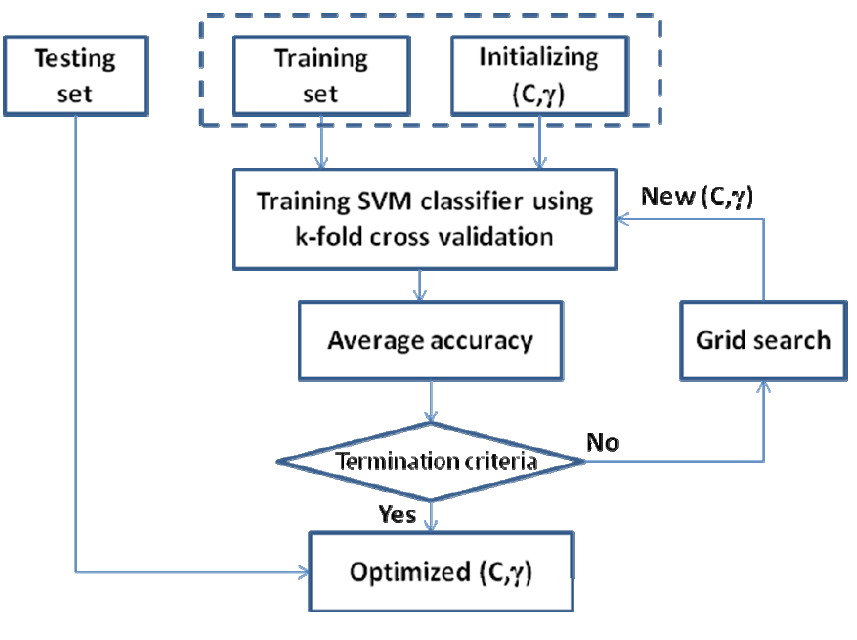
Figure 3. Selection of optimal parameters of Kernel function using Grid